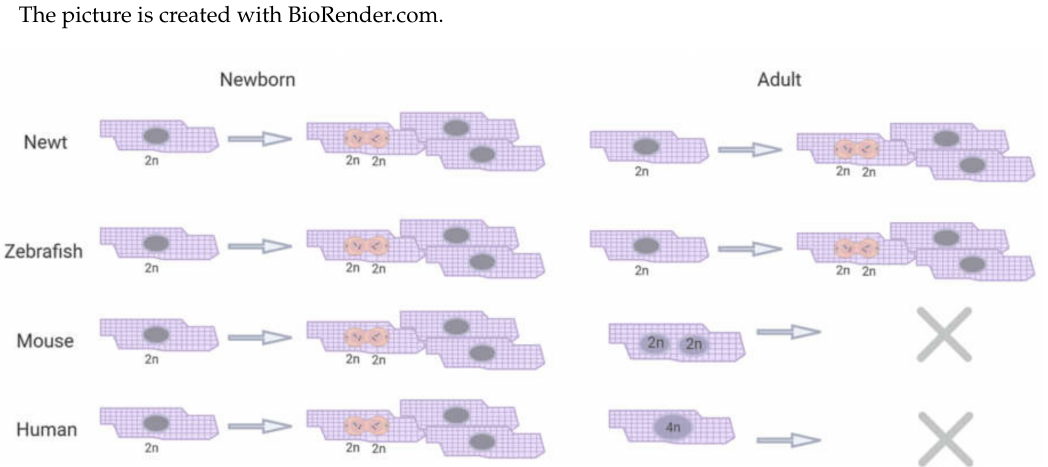
Figure 2. Total DNA content per cardiomyocyte in relation to their proliferative capacity. Newt and zebrafish cardiomyocytes stay mononucleated, diploid, and proliferative their whole life. Newborn mouse and human cardiomyocytes have similar characteristics as newt and zebrafish, but the mouse cardiomyocytes become binucleated and human cardiomyocytes become tetraploid when they become adults. Simultaneously, these cardiomyocytes lose the ability to